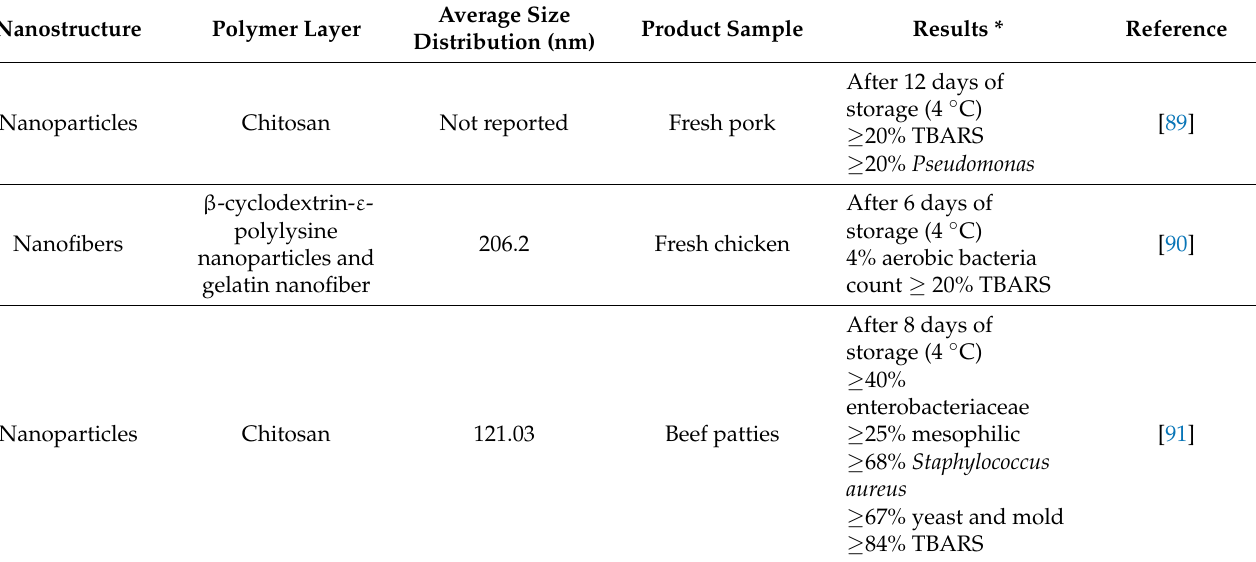
Table 2. Nanosystems used in meat